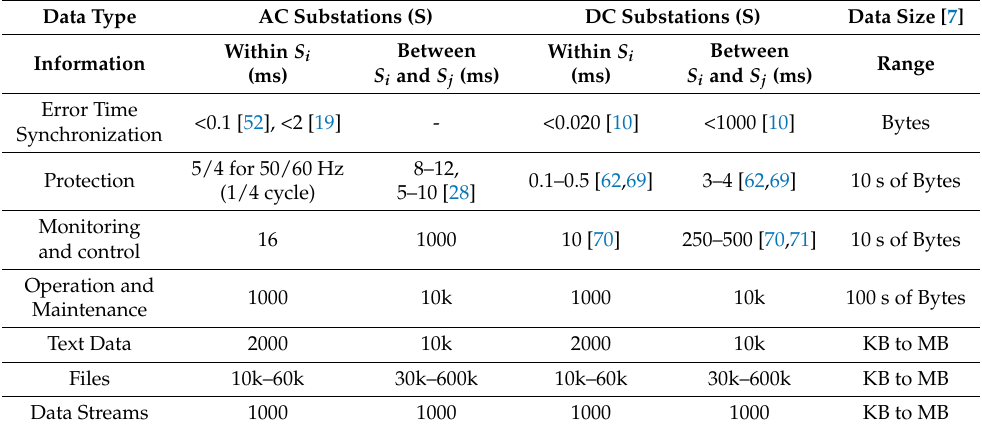
Table 6. Data exchange timescale & size requirements (AC based on IEEE P1646 vs.